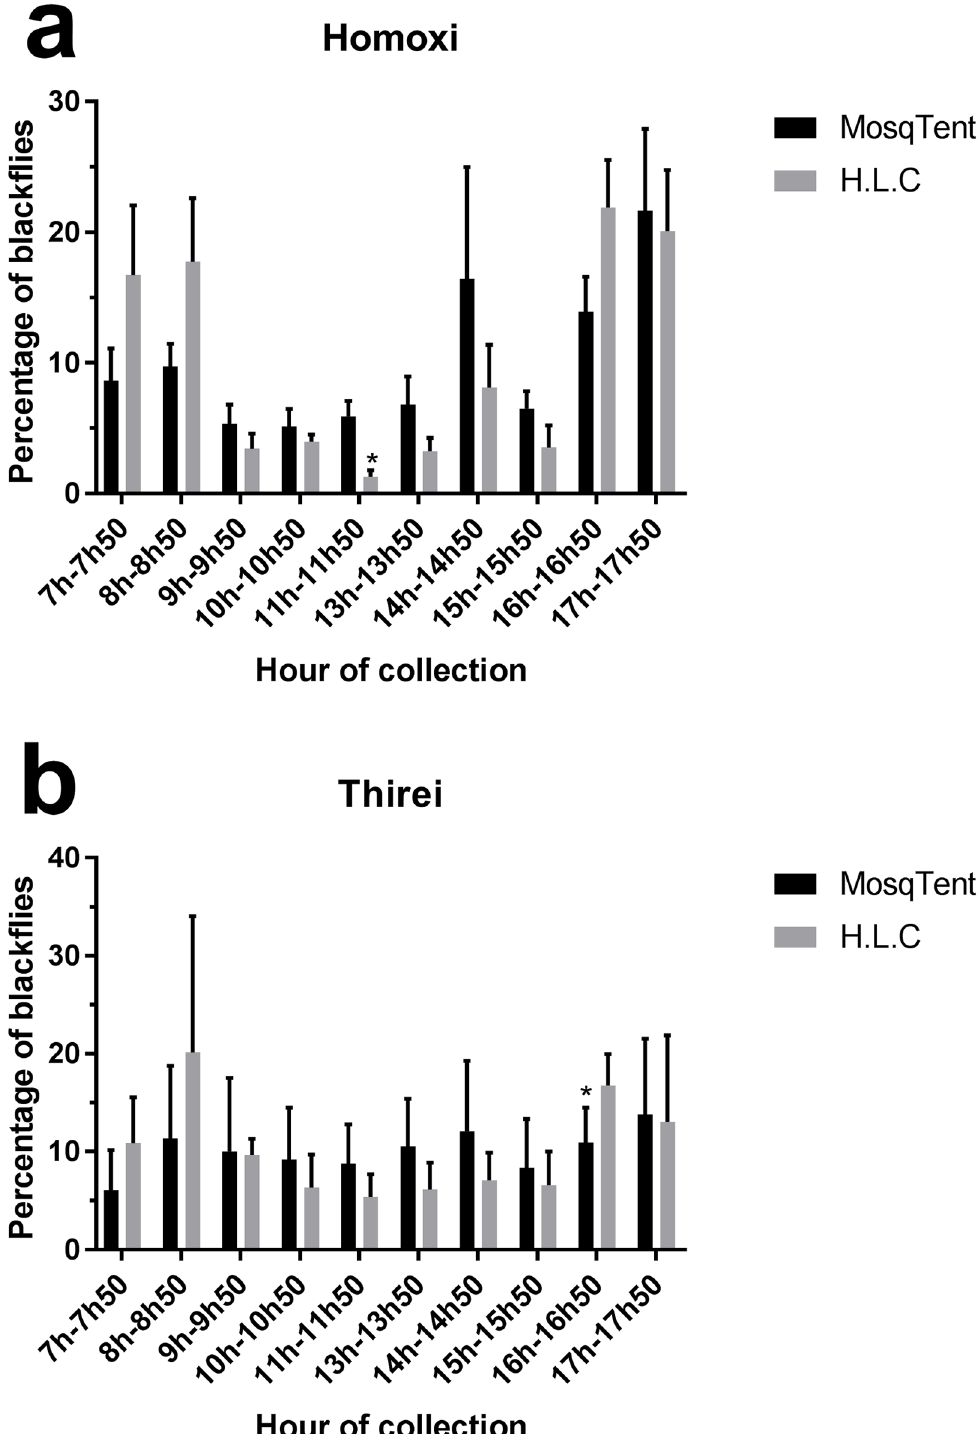
Fig 5. Bite activity of Simuliidae at Homoxi (a) and Thirei (b).